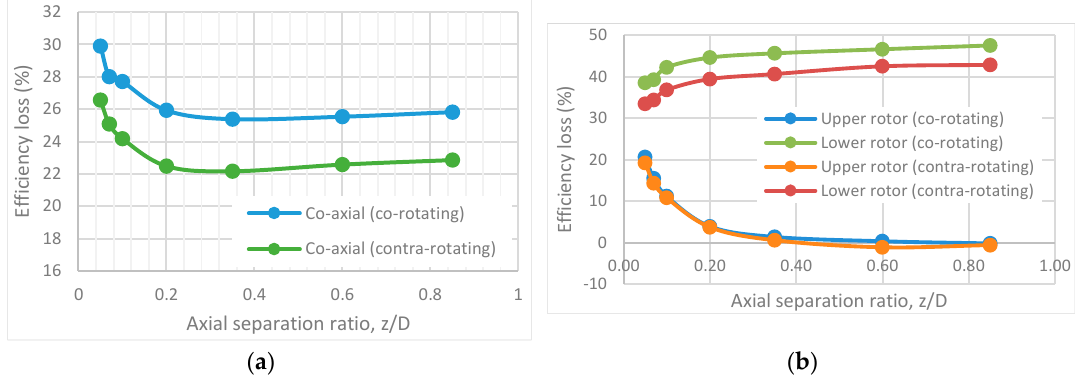
Figure 16. Performance comparison quantifying losses/gains of co-rotating rotor co-axial and conventional co-axial setups over two isolated rotors (overall thrust, 15 N). ( a ) Co-axial system performance; ( b ) Individual rotor performance.